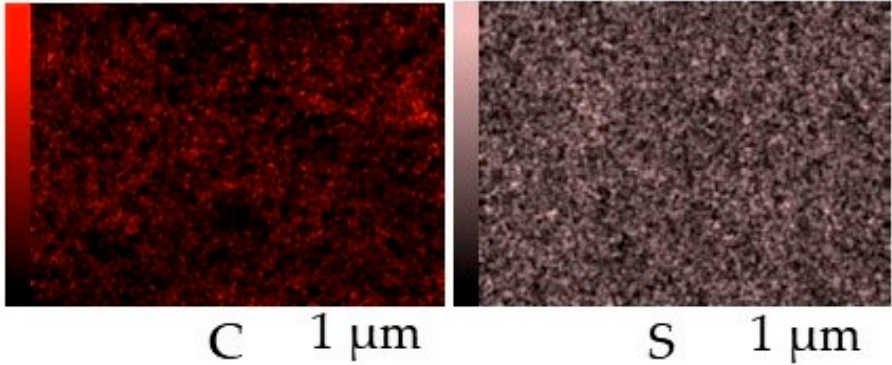
Figure 24. Distribution of sulfur (S) and carbon (C) in the catalyst after the blank test by scanning electron microscopy (SEM).